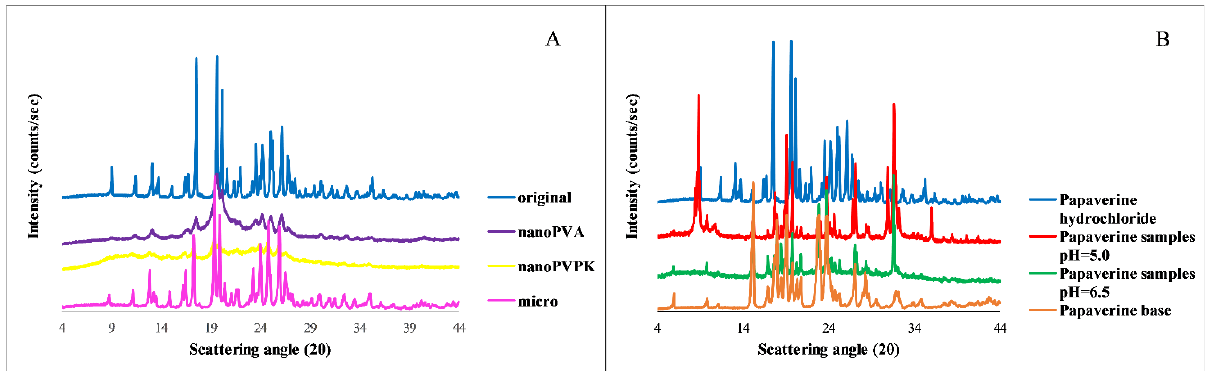
Figure 3. PXRD diffractogram of the original, micronized and nanonized substances ( A ) and furthermore the papaverine samples from the solubility measurements (pH = 6.5 and pH = 5.0) compared to the solid papaverine base and papaverine hydrochloride salt ( B ).